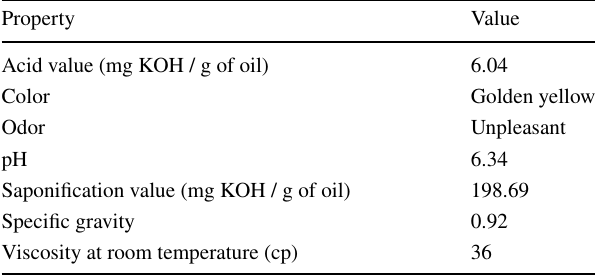
Table 2 Physicochemical properties of jatropha oil